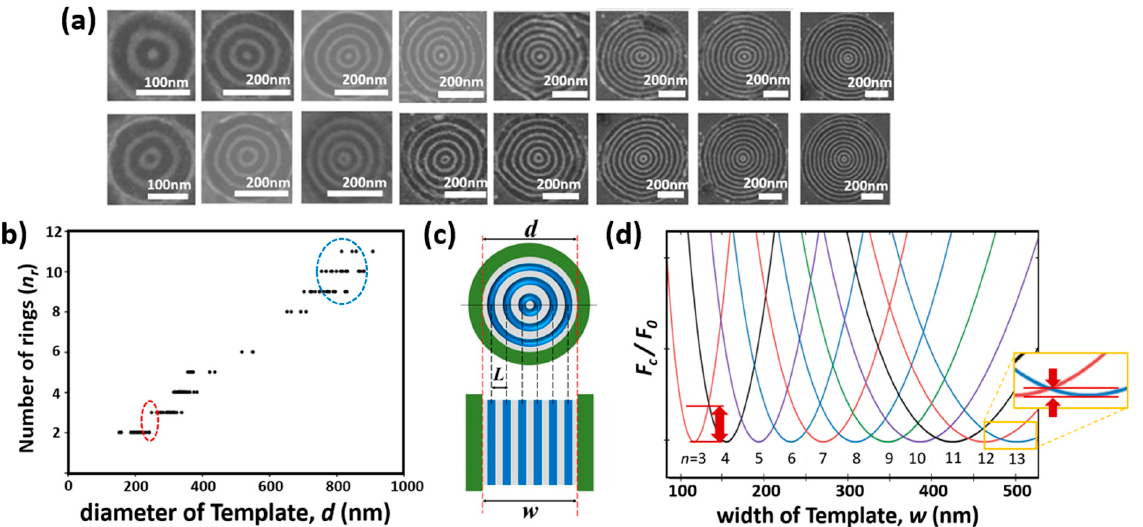
Figure 5. ( a ) SEM images of BCP concentric ring patterns fabricated with guiding templates of various sizes. Rows display the PDMS concentric rings with (top) and without (bottom) the PDMS central dot. ( b ) Number of concentric rings ( n r ) as a function of the diameter of the template ( d ). ( c ) Schematics of concentric rings formed in a circular trench template (top) and a line pattern formed in a linear trench template (bottom). ( d ) Free energy per confined polymer chain relative to the bulk free energy per polymer chain ( F c /F 0 ) as a function of the template width ( w ) for each value of n . Red arrows indicate the difference in the free energy between the commensurate and incommensurate states.